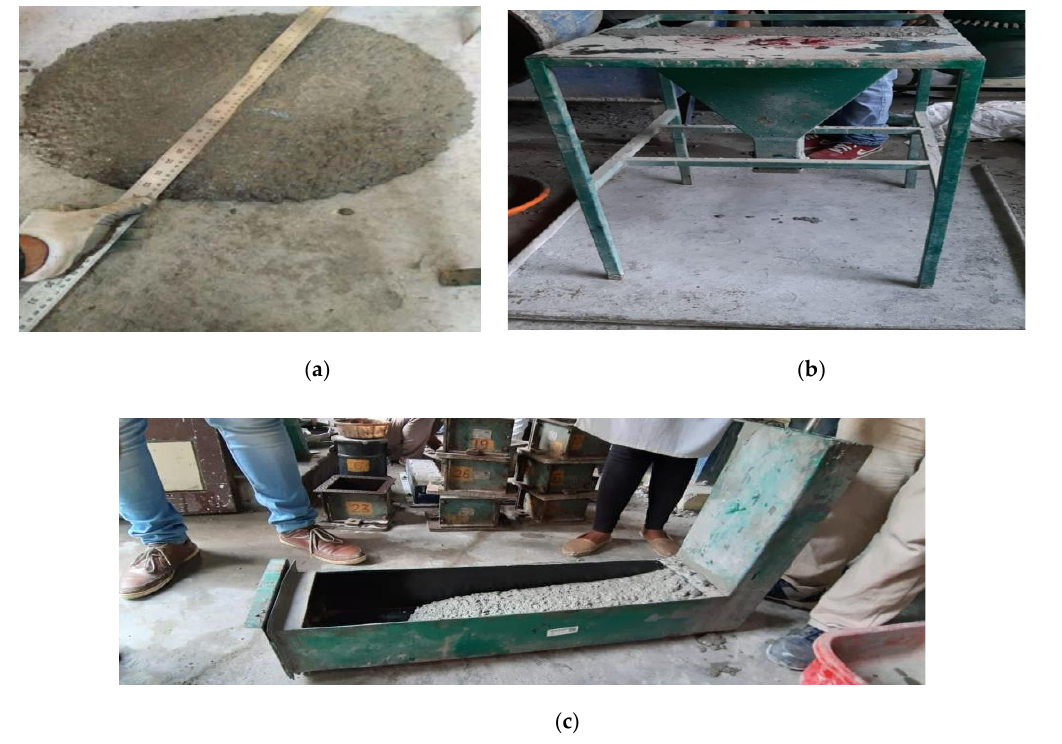
Figure 1. SCC o properties measurement: ( a ) slump flow test; ( b ) V-funnel test apparatus; ( c ) L-Box test apparatus.